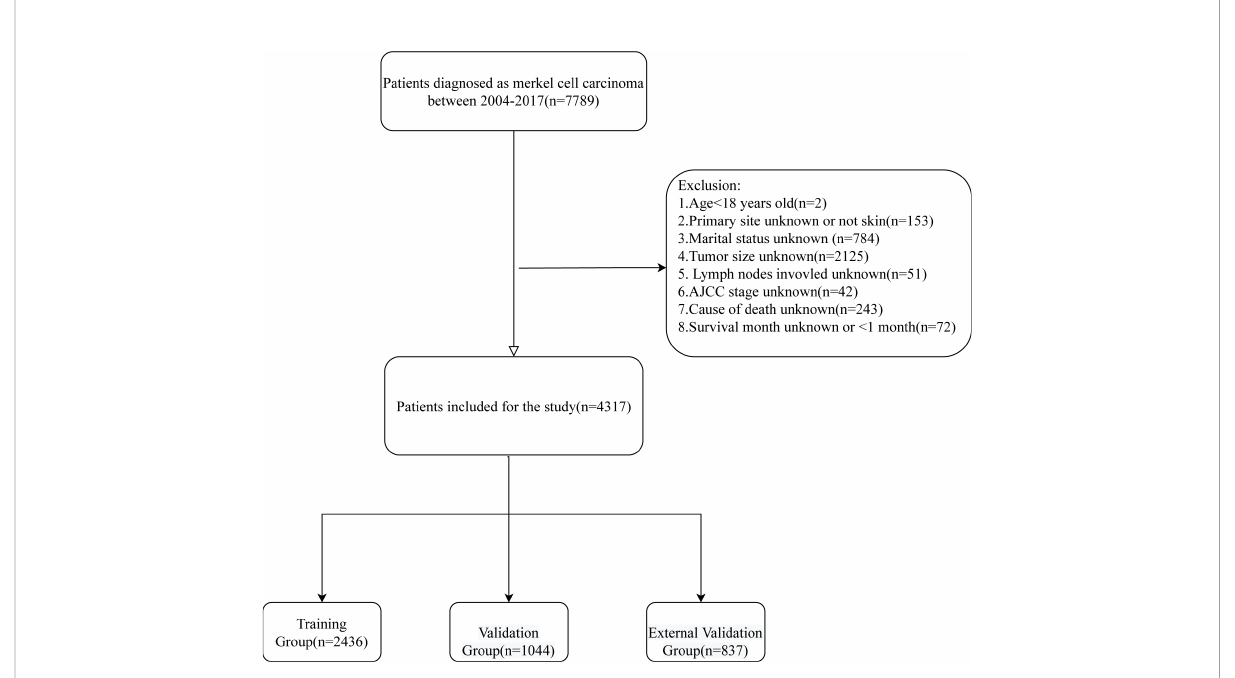
FIGURE 1 Flow chart for inclusion and exclusion of